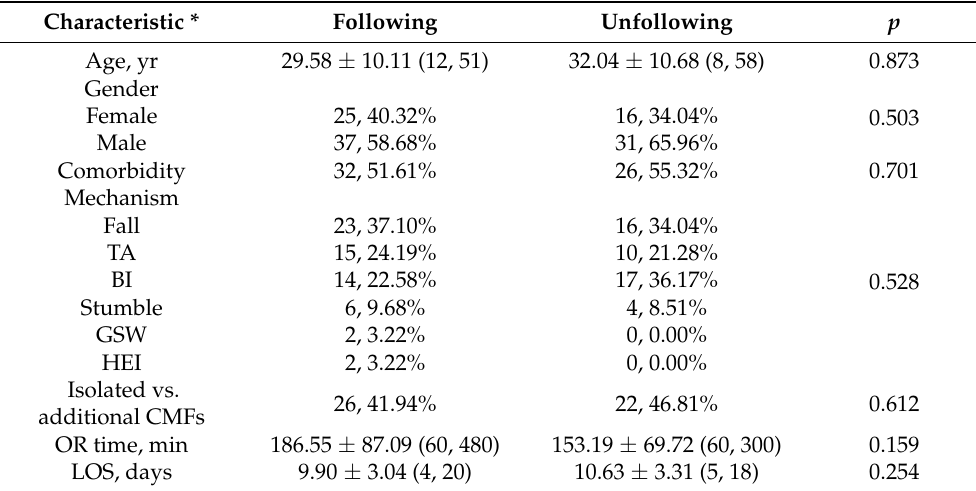
Table 1. CMFs Groups: treatment algorithm following versus unfollowing.